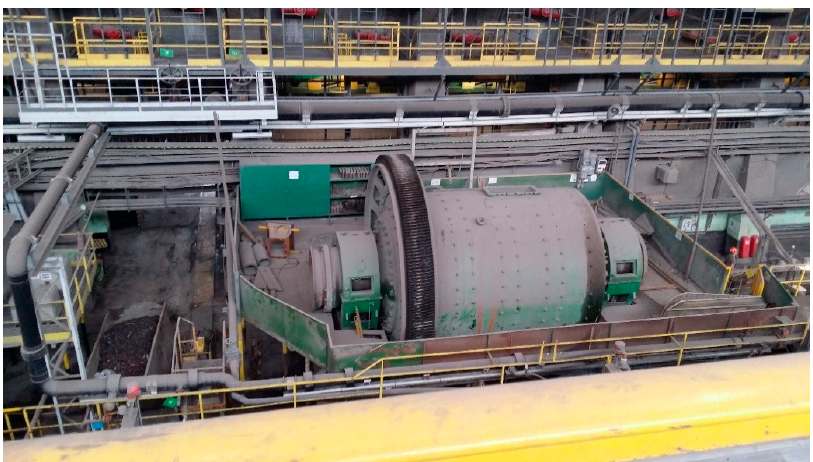
Figure 1. Ball mill of the primary milling stage with the visible gear ring.